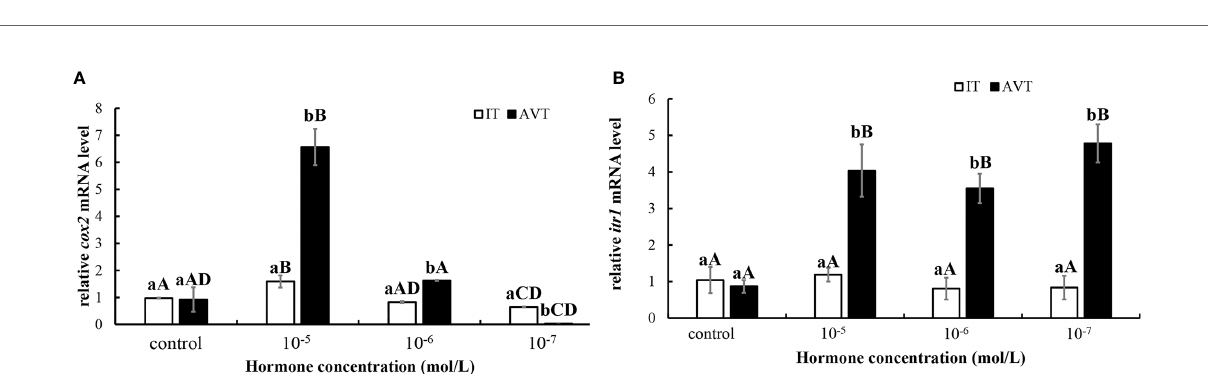
FIGURE 6 | Dose-dependent effects of AVT and IT on the expression of cox2 and itr1 mRNAs in guppy ovary fragments. Ovary fragments were incubated with AVT or IT at the concentrations of 10 − 5 mol/L, 10 − 6 mol/L or 10 − 7 mol/L for 3 h, and the levels of cox2 (A) and itr1 (B) mRNAs were measured using qPCR (n=5). The results are presented as the mean ± SEM and as fold changes in the expression levels versus the corresponding controls. Different capital letters indicate signi fi cant differences between the groups treated with each concentration of a hormone (P < 0.05). Different lowercase letters indicate signi fi cant differences between the two hormone treatments at the same concentration (P <